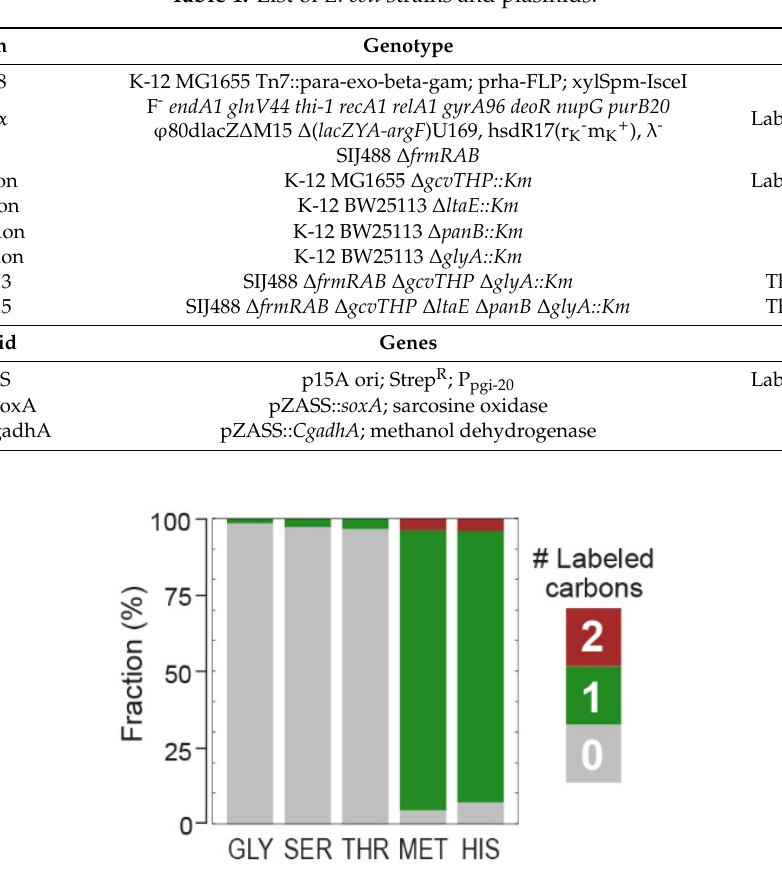
Table 1. List of E. coli strains and plasmids.